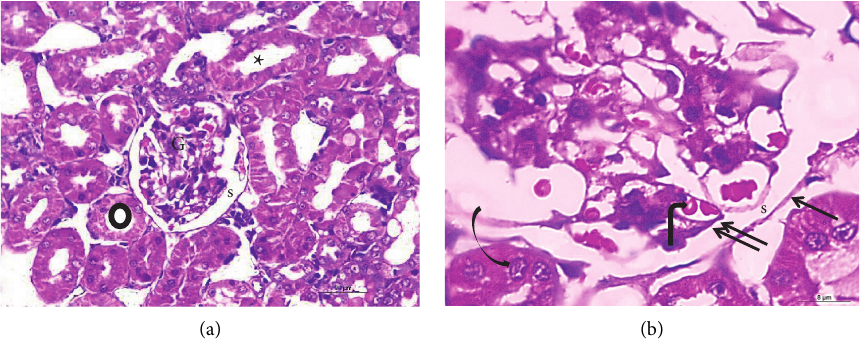
Figure 2: Representative micrographs of H&E-stained sections of the young group ( N � 10) showing renal corpuscles with a normal glomerular tuft G containing glomerular capillaries (bent arrow). Bowman’s space (s) is located between the two layers of Bowman’s capsule: parietal layer (arrow) and visceral layer (double arrows). Proximal (asterisk) and distal (circle) convoluted tubules are also seen with normal tubular epithelium (arched arrow). H&E (a): 40x, scale bar � 20 µ m; (b): 100x, scale bar � 8 µ m. N � number of rats/group.